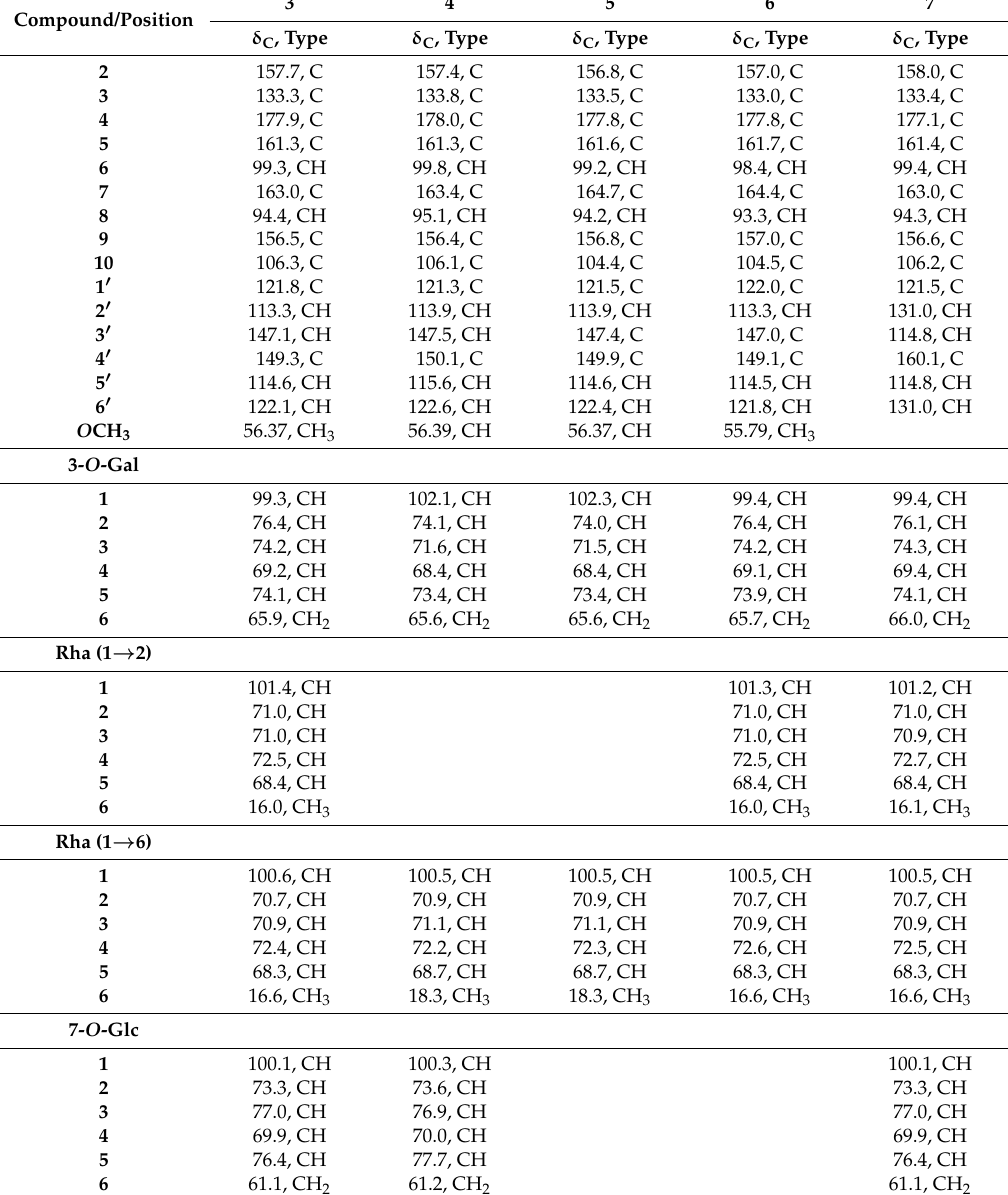
Table 2. 13 C-NMR assignments (100 MHz) for compounds 3 – 7 , δ (ppm).